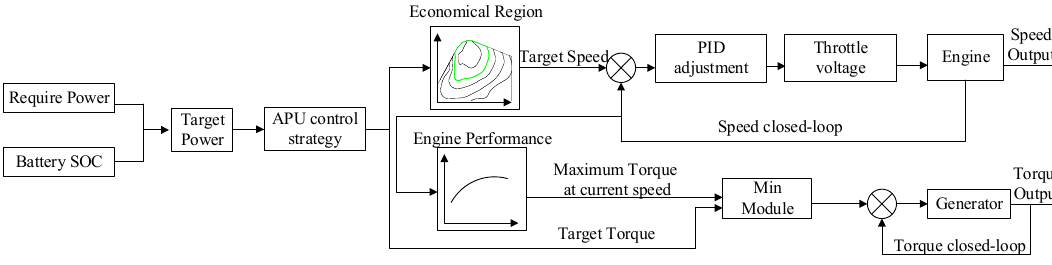
Figure 11. APU system control schematic.